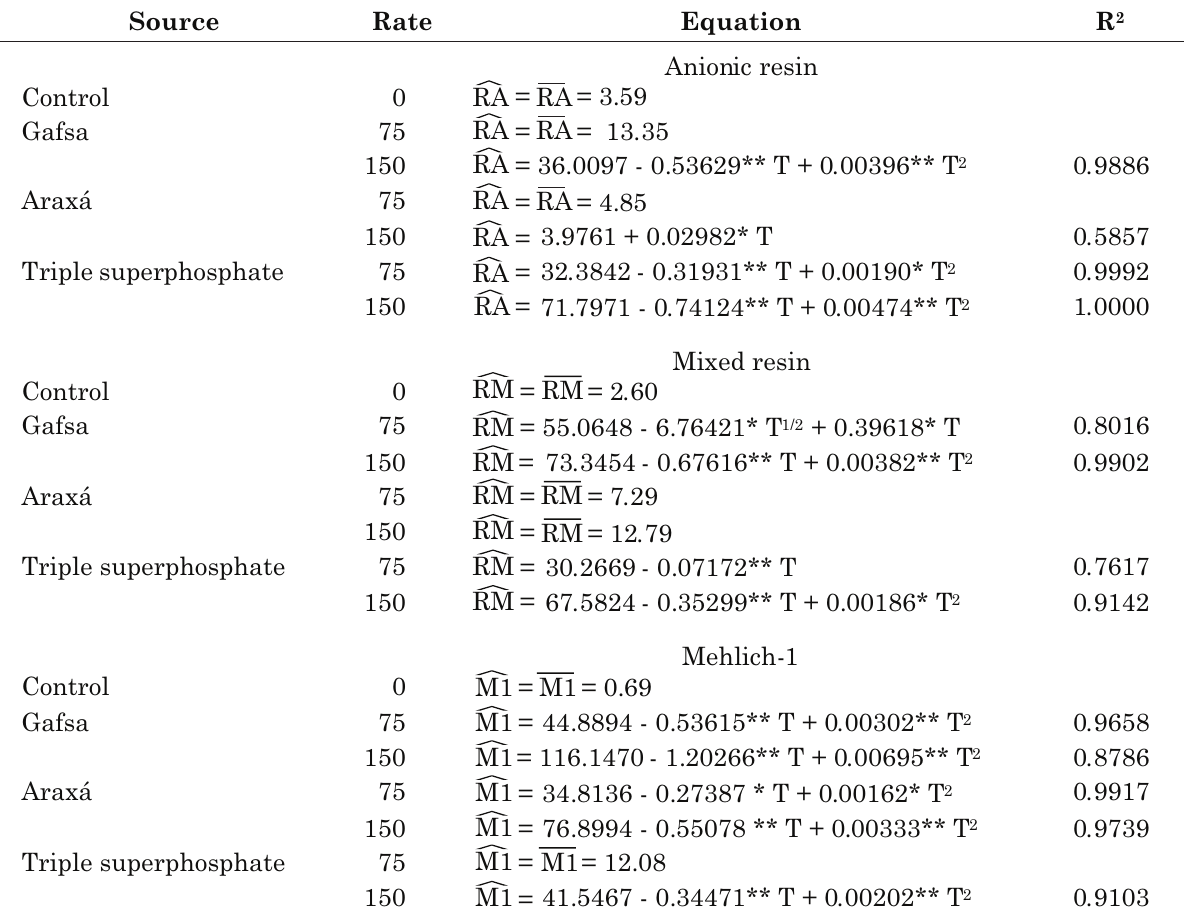
*, **: Significant at 5 and 1 %, respectively, by the F